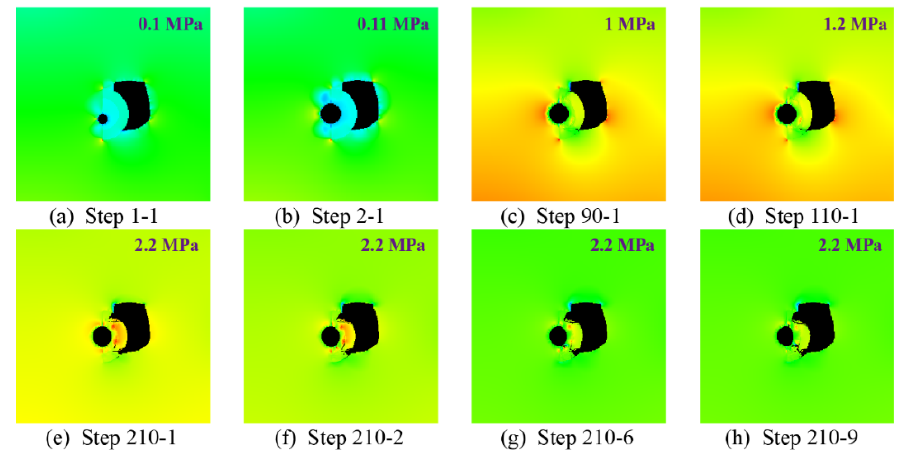
Figure 13. Numerical calculation results of the damage model of the composite surrounding rock under the influence of a water-rich cave: ( a – h ).